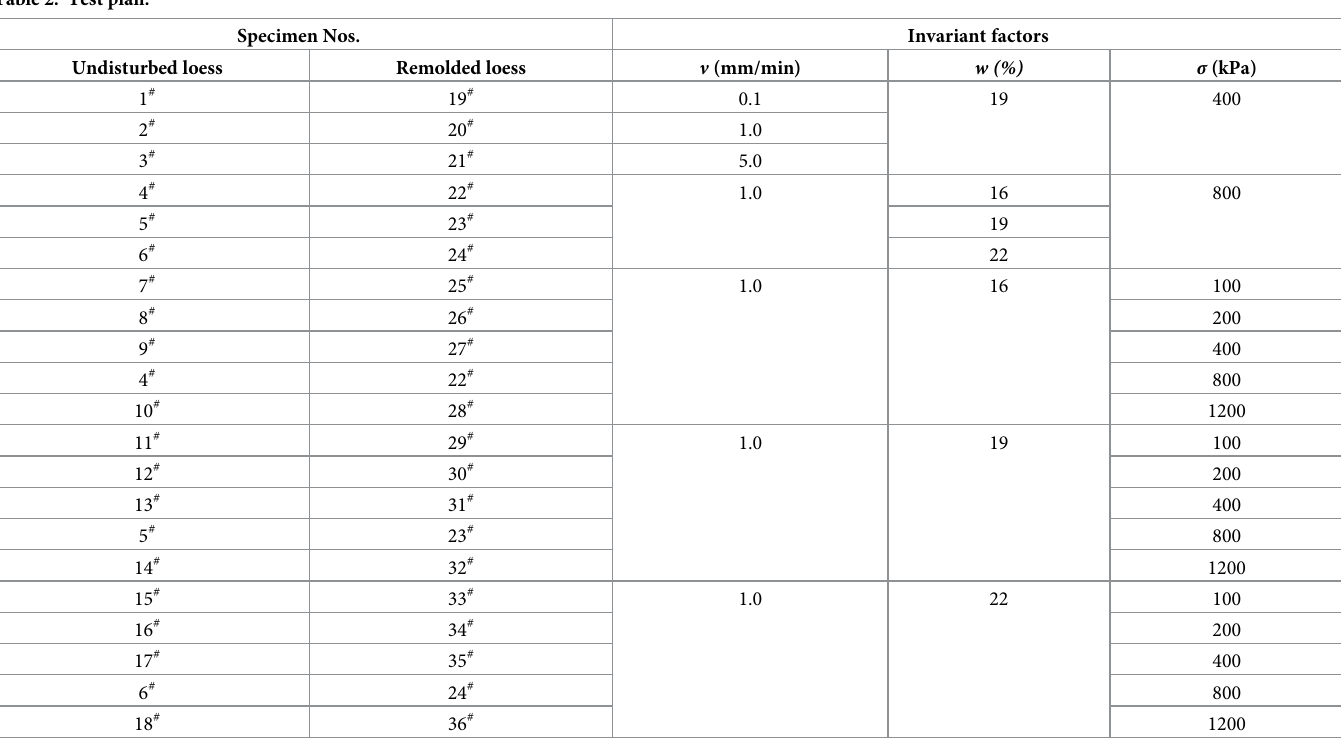
Table 2. Test plan.